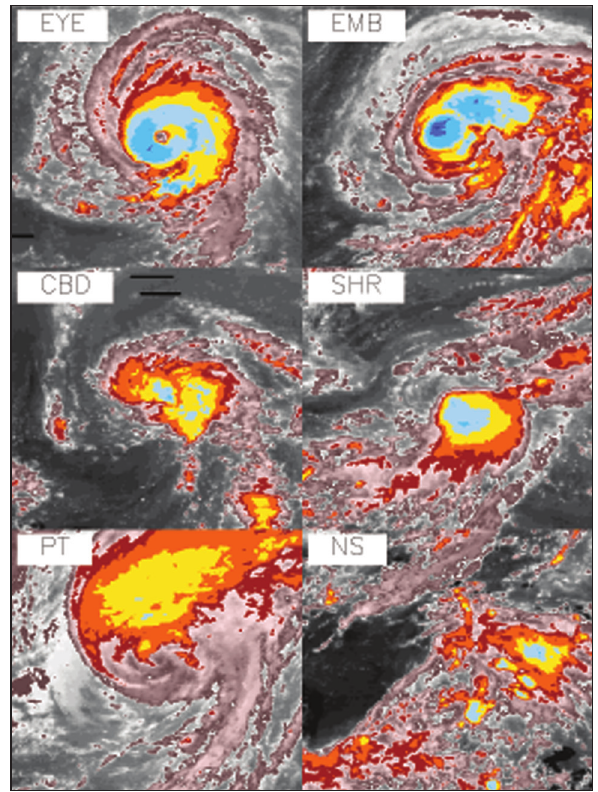
Figure 1: Sample images for (top left to bottom right): eye (EYE), embedded center (EMB), curved band (CBD), shear (SHR), post tropical (PT) and no storm (NS) scenarios taken from the typological guidance available to users as they classify on